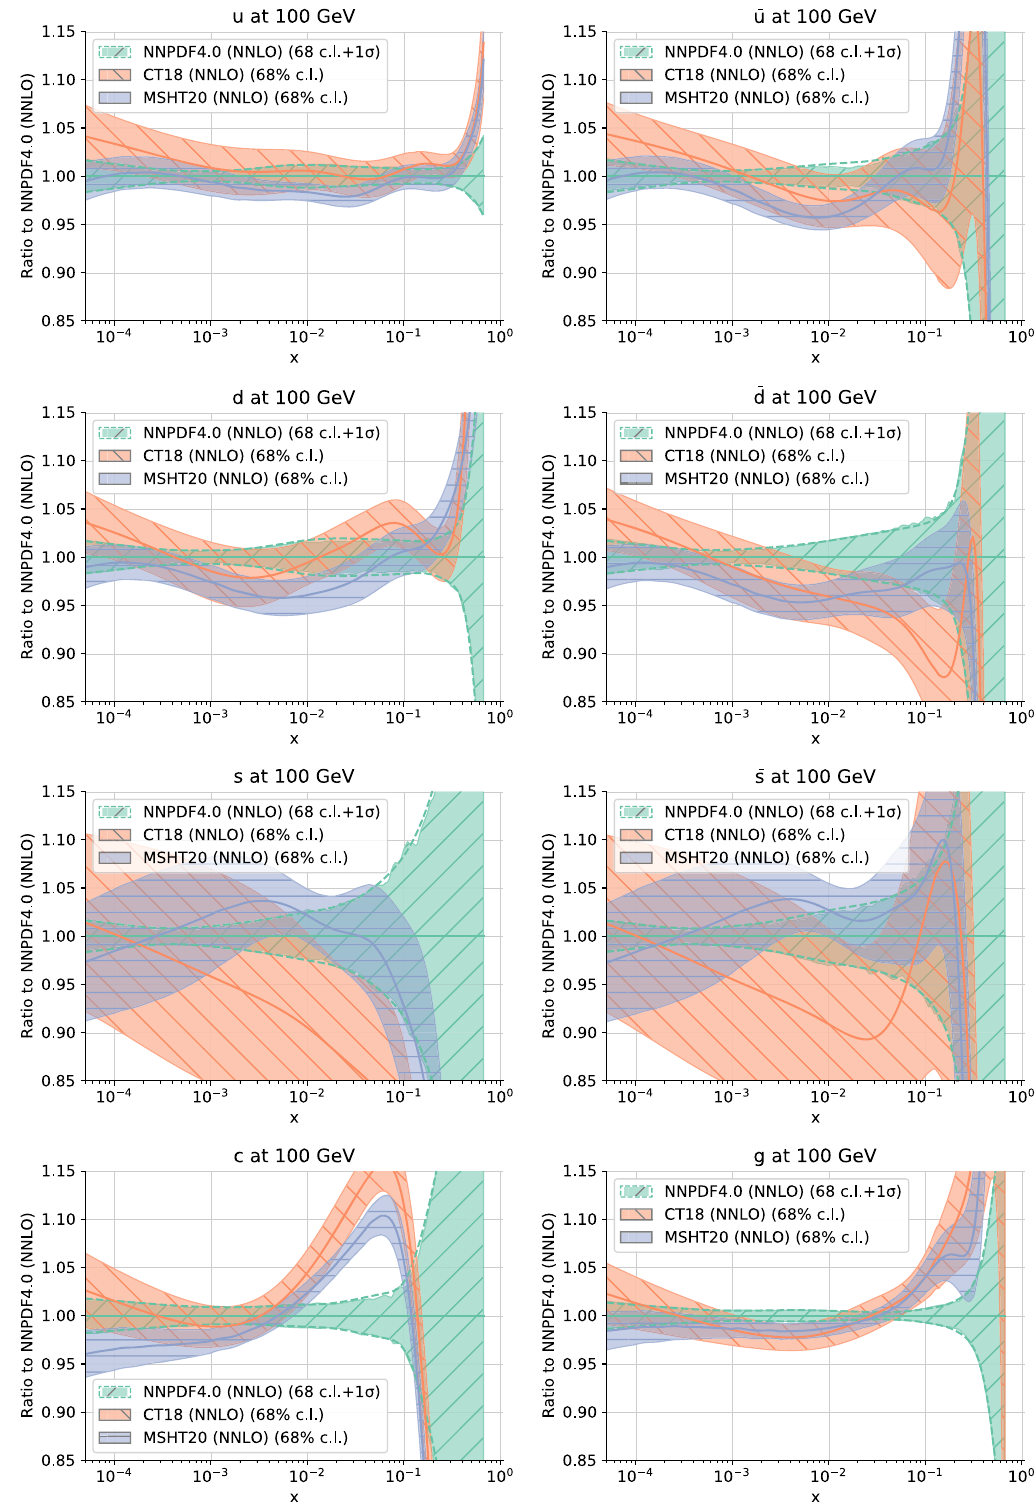
Fig. 21 Comparison between the NNPDF4.0, CT18 and the MSHT20 NNLO PDF sets. The up, antiup, down, antidown, strange, antistrange, charm and gluon PDFs are shown at Q = 100 GeV, normalized to